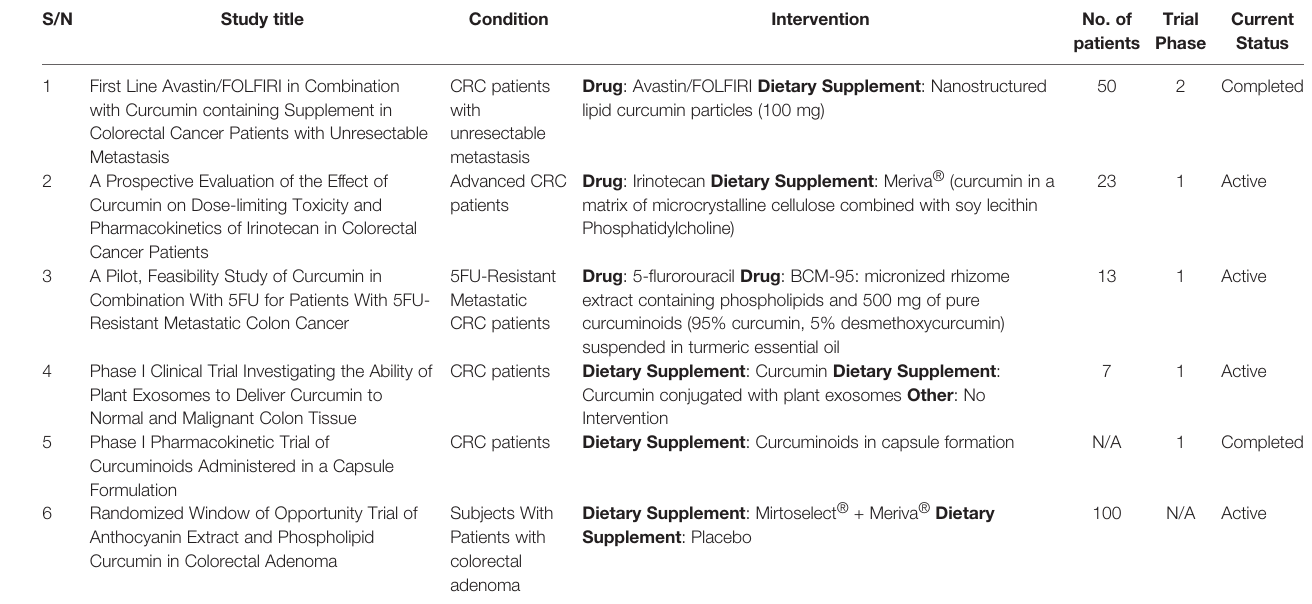
TABLE 2 | Effects of curcumin on human clinical trials